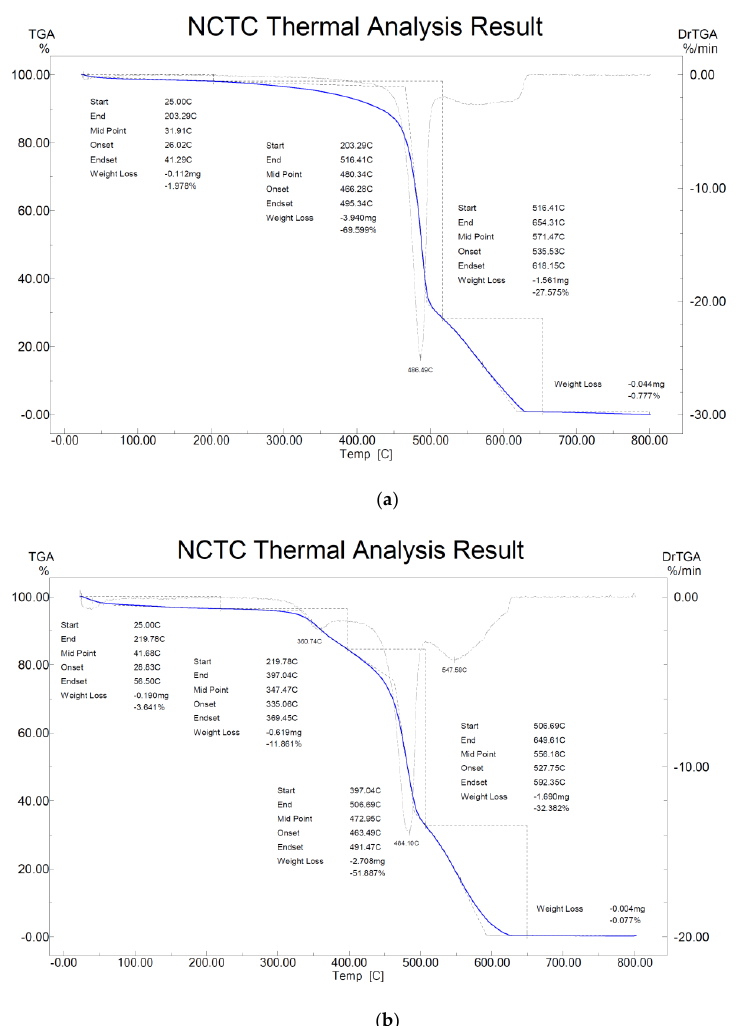
Figure A2. DTA analysis of ( a ) virgin MF and ( b ) virgin UF membranes at the nitrogen gas flow rate of 50 mL/min.